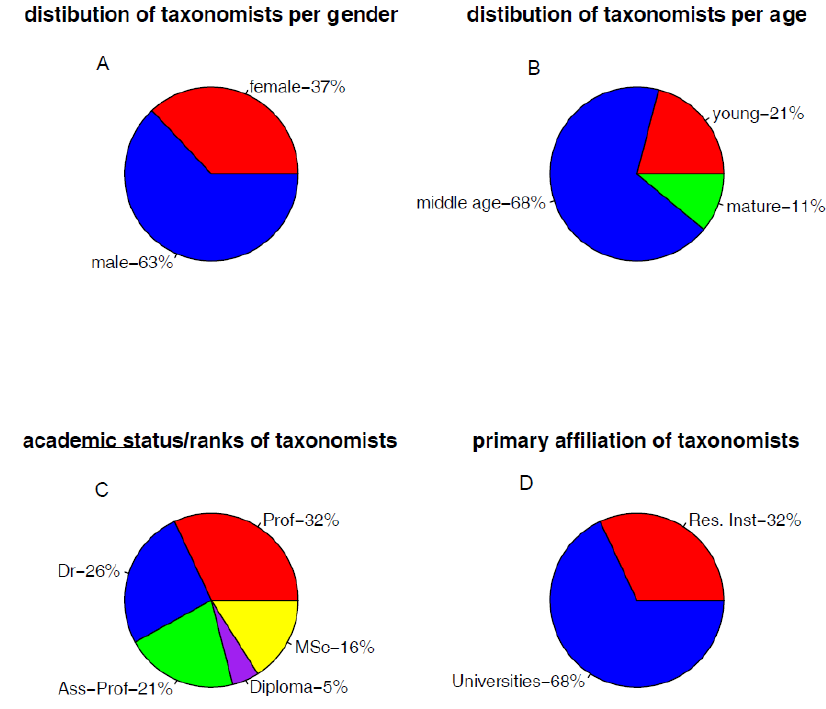
Figure 2. Summary of demographic structure of population of taxonomists who took part in this study. Dr = doctor; Ass-Prof. = associate professor; Prof. = professor; Res. Inst = research institutions.